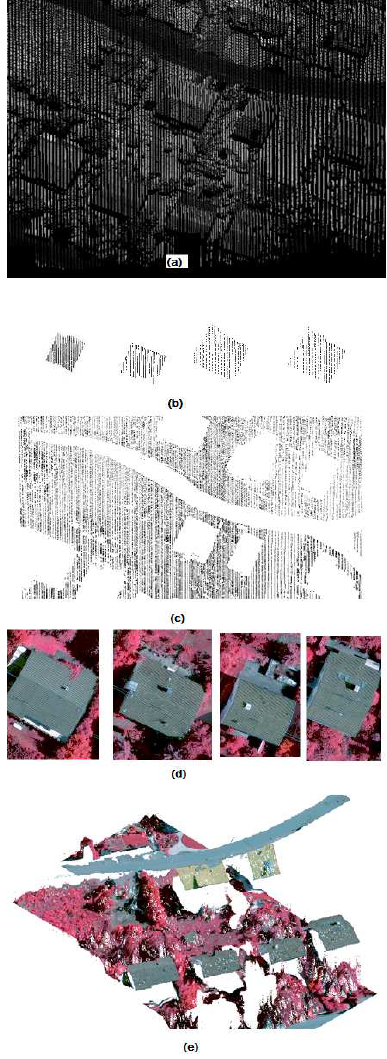
Figure 1. This figure shows the process of the proposal for this research study. Figure (1a) shows a point clouds from an urban area. Figure (1b) shows the extracted of four building in this area form the point clouds, and Figure (1c) shows the bare point clouds after subtracting all extracted object from the point clouds. Figure (1d) shows extracted buildings from the image after transforming and registering extracted building from the point clouds on the image. Figure (1e) shows an isometric view from reconstruction of the 3D model after transforming and registering extracted object from the image on the 3D model space or DTM developed from the point